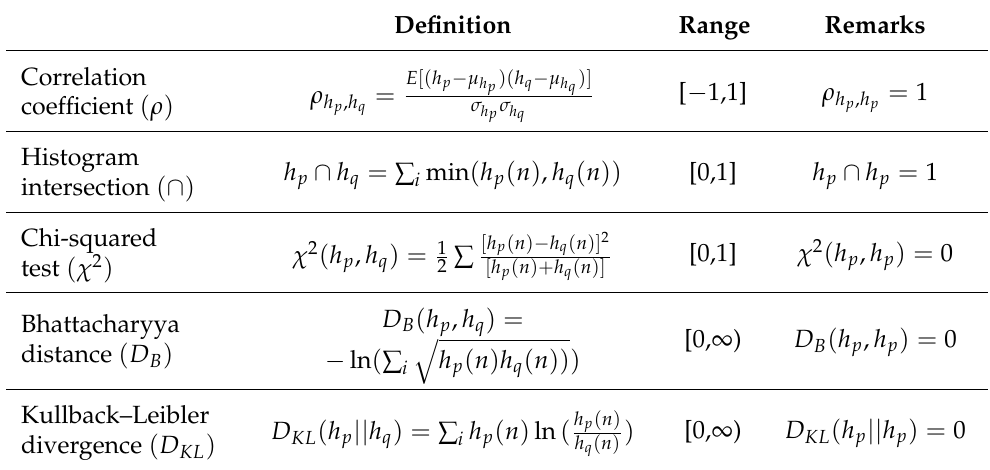
Table 1. Definition of Measures qualifying the similarity between histograms of the gradient distribution.